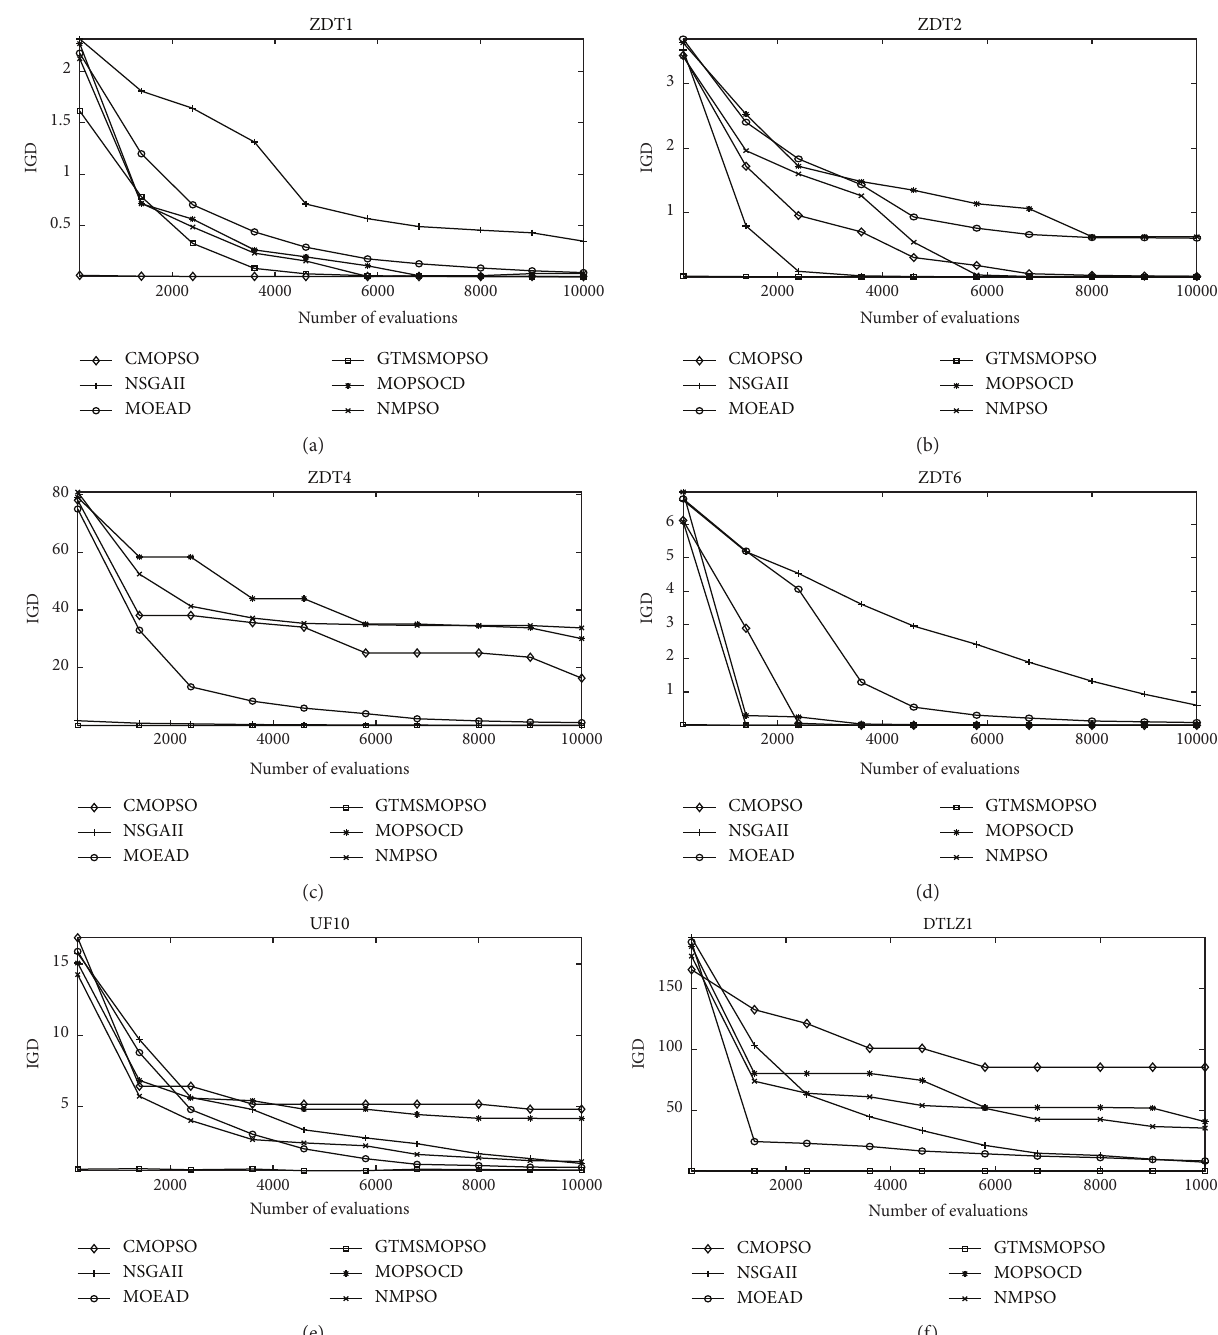
Figure 9: Convergence curves of different algorithms on 6 test